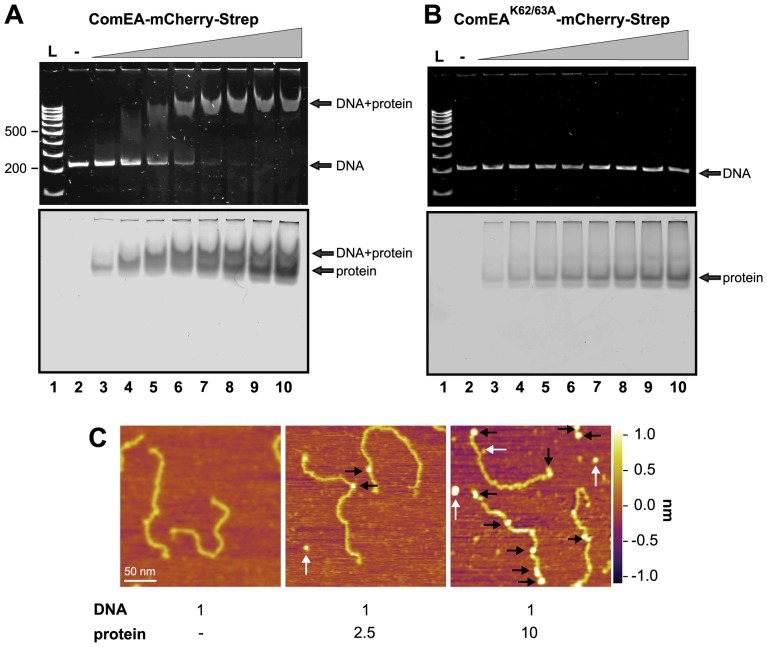
ComEA but not ComEAK62/63A binds to DNA in vitro.EMSA using the 200comEA gene as a probe (panels A and B). A total of 0.4 pmol of DNA was incubated without or with increasing amounts of the ComEA-mCherry-Strep (A) and ComEAK62/63A-mCherry-Strep (B) protein (lanes 2 to 10: 0, 2, 4, 6, 8, 10, 12, 16, and 20 pmol of protein). Free DNA, free protein, and the DNA/protein complex are indicated by the arrows. L: DNA ladder (representative bp are indicated on the left). Panel C: AFM images of DNA, proteins, and DNA/protein complexes absorbed on mica. AFM images from left to right: bare DNA fragments (DNA to protein ratio 1∶0); DNA/protein complex at a molecular ratio of 1∶2.5; DNA/protein complex at a molecular ratio of 1∶10. The proteins bound to the DNA are marked with black arrows; unbound proteins are labeled by white arrows. The height or Z scale is shown on the right and is the same for all three panels displaying 270 nm×270 nm scan areas.